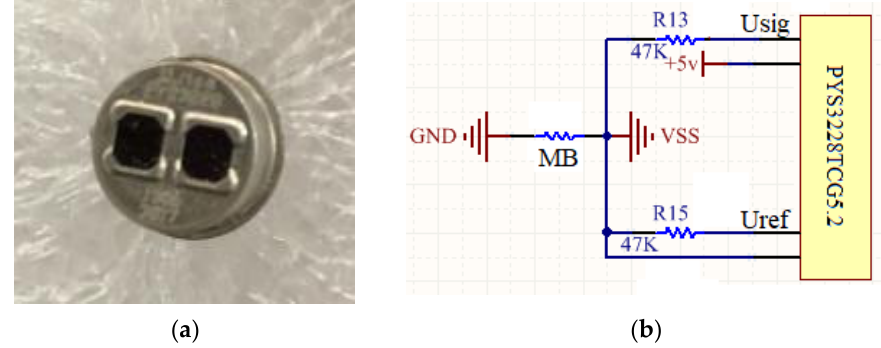
Figure 7. ( a ) The mathematical model and ( b ) experimental tests of paraboloid concentrator.